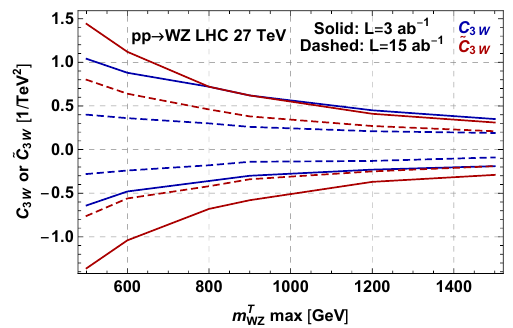
Figure 9 . 95% bound on the c 3 W and ~ c 3 W Wilson coe(cid:14)cients computed with four and two equally spaced angular bins for (cid:30) Z and (cid:30) W respectively, in function of the largest WZ system transverse mass bin used for the 27 TeV LHC with 3 ab (cid:0) 1 (solid) and 15 ab (cid:0) 1 (dashed) of integrated luminosity. A systematic error of 5% has been